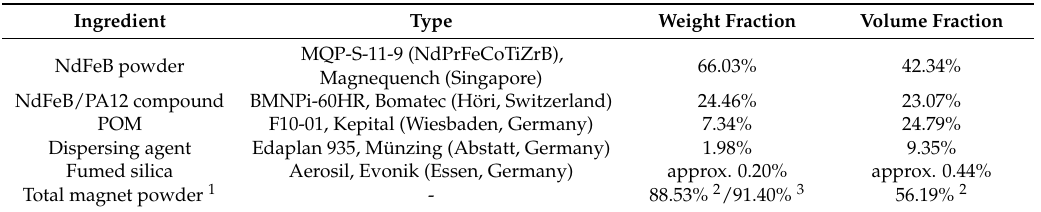
Table 2. Composition of the developed flexible polymer-bonded compound filament